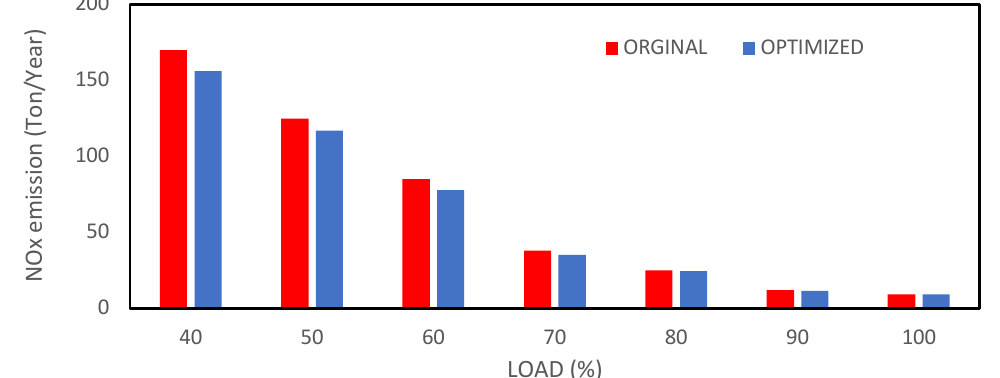
Figure 5. NOx emission diagram (Ton/Year) at different partial loads for the original and optimized gas